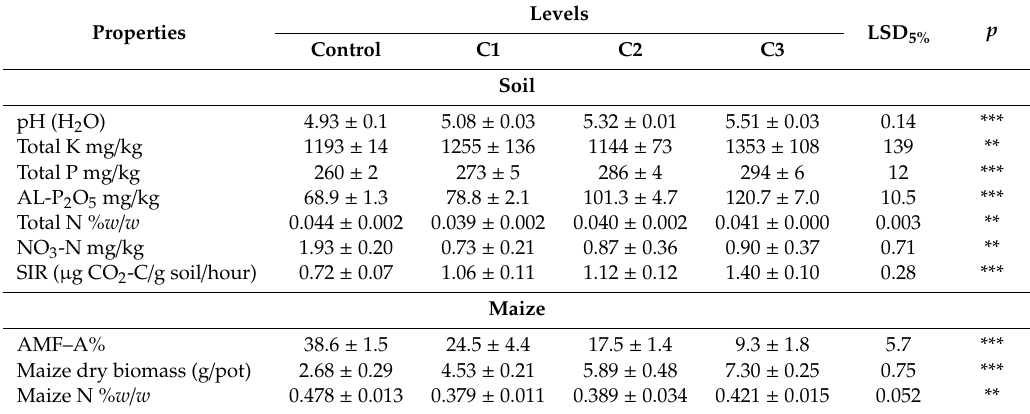
Table 4. Significant e ff ect of individual compost treatment levels (% w / w ) on the properties of acidic sandy soil and maize. Data are mean ± sd of the